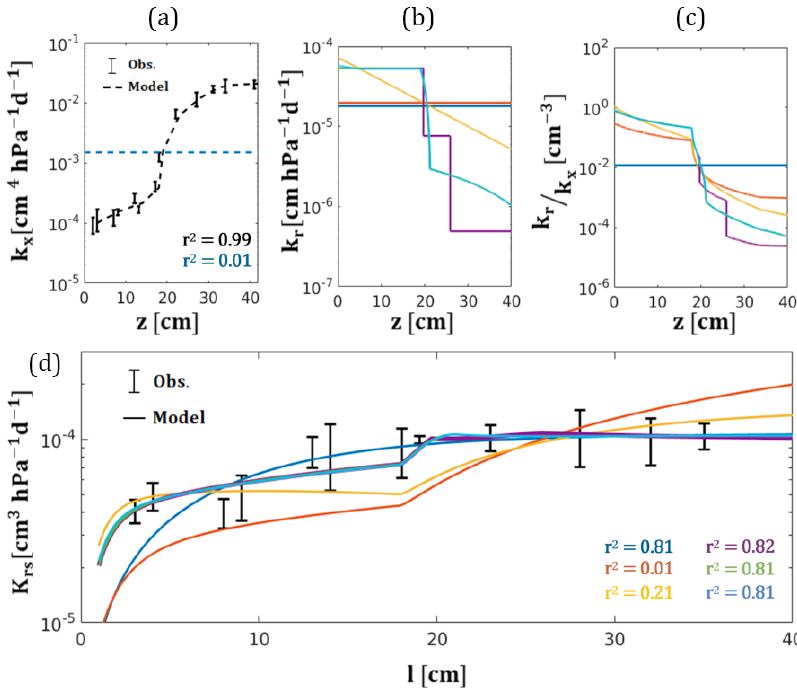
Figure 9. Hydraulic properties of the maize brace roots: axial and effective conductance of different root types as function of distance from root tip (dark symbols, panels a and d , respectively). Data presented as dots are average of 5 measurements and the error bars represent the standard deviations. In panel (a) , two different scenarios were tested: constant (dark blue dashed line) or linear piecewise (black dashed line) axial conductance. Profiles plotted as solid lines are the best profiles obtained from optimization of root radial conductivity parameters through simulations of water flow into unbranched roots of varying length (d) . (b) best fitted profiles of radial conductivity that reproduce measured profiles of effective conductance. (c) ratio of radial conductivity to axial conductance derived from the analysis along the root axis. The best fitted axial conductance profile was used for each scenario except for the uniform root (dark